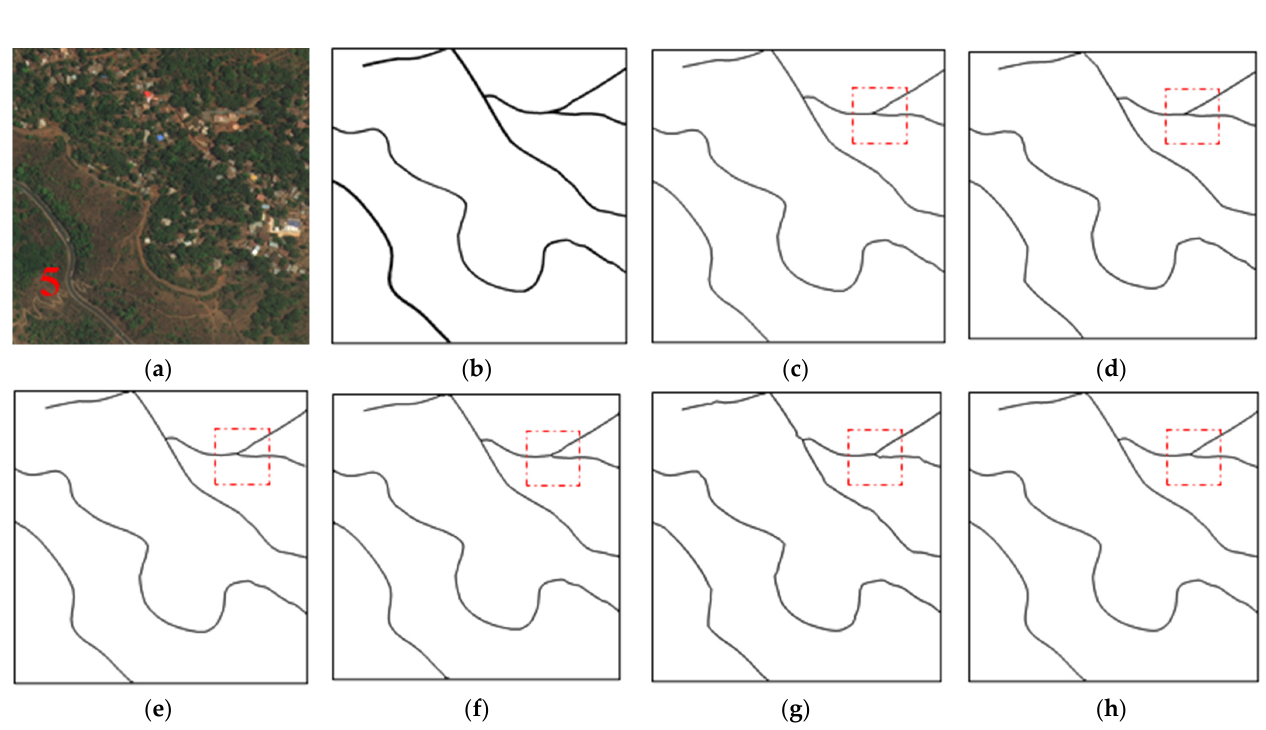
Figure 13. Experimental results for test image 5. ( a ) Original optical image. ( b ) Labelled road map. ( c ) Reference centerline map. ( d ) Result of the proposed method. ( e ) Result of the MT method. ( f ) Result of the ZST method. ( g ) Result of the MARS method. ( h ) Result of the NMS method.